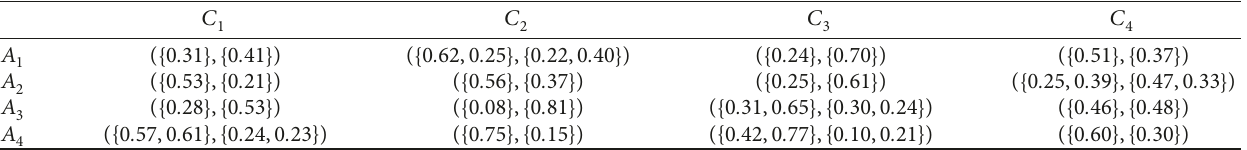
Table 3: Dual hesitant fuzzy